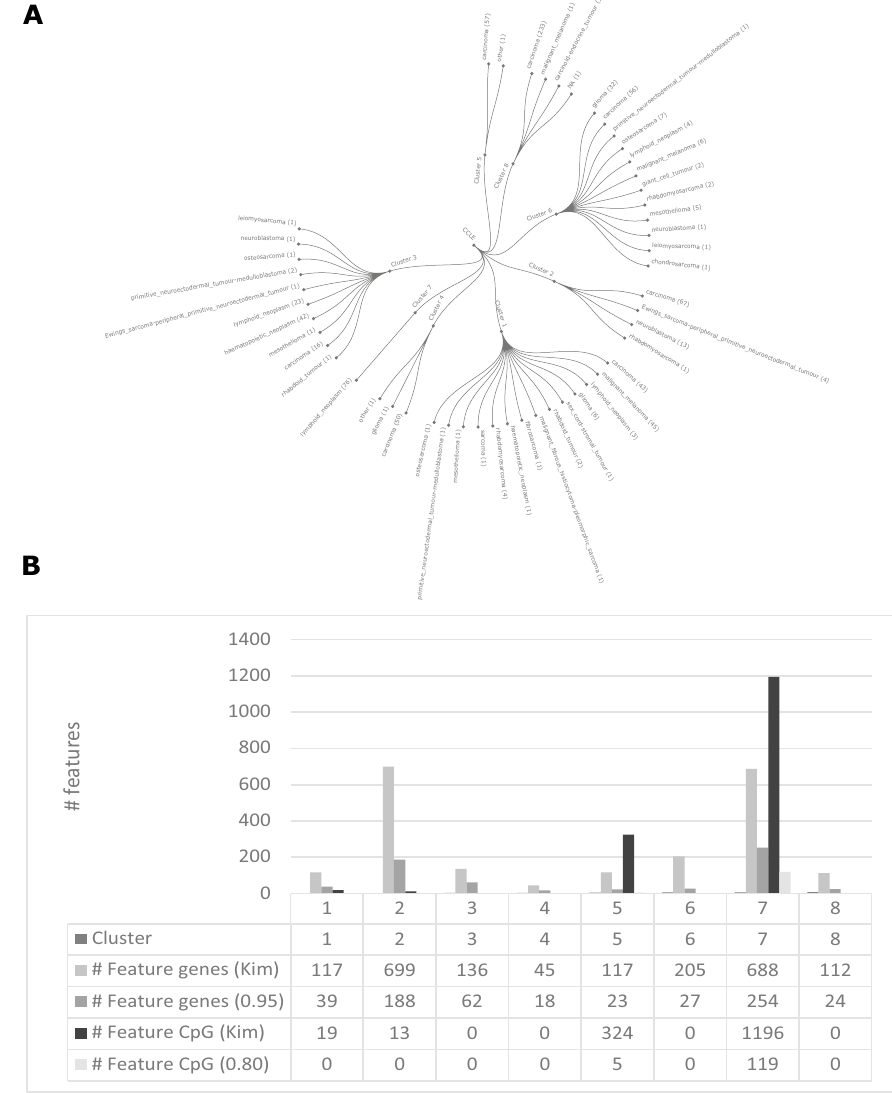
Figure 2. ( A ) The histology of each cluster member as defined by the 2019 CCLE metadata. Here, it becomes apparent that there are a number of clusters with mixed cancer types, but more importantly, there are clusters that show strong homogeneity. ( B ) Histogram for the number of feature genes and DNA promoter regions with Kim score and a more stringent feature